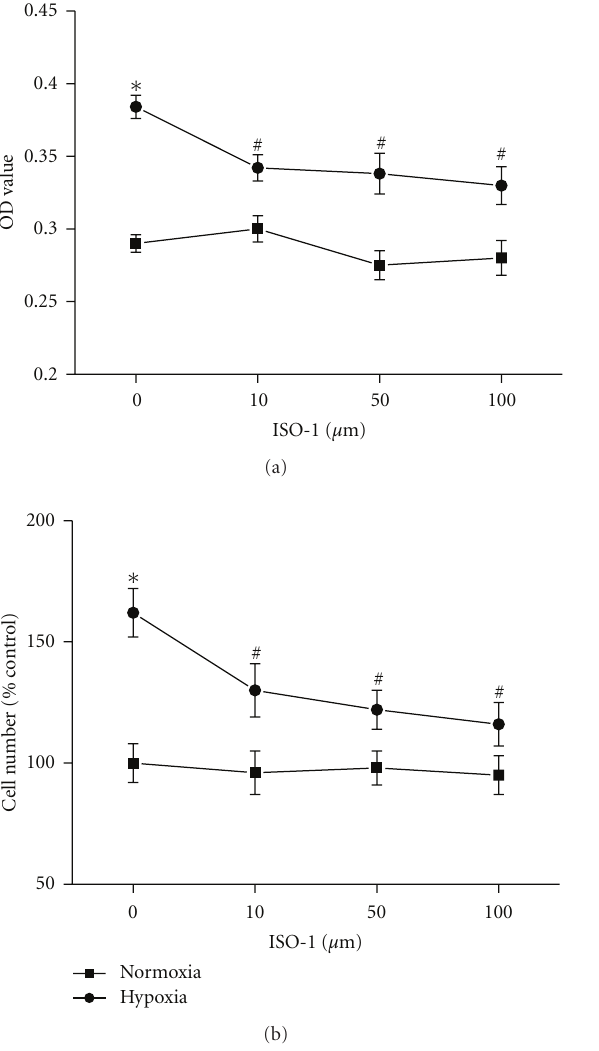
Figure 4: E ff ects of MIF on proliferation of rat PASMCs. Cell proliferation was demonstrated by MTT (a) and direct cell counting (b). MIF (100, 200 ng/mL) could directly promote PASMCs prolif- eration. n = 8. ∗ P < 0 . 05 versus